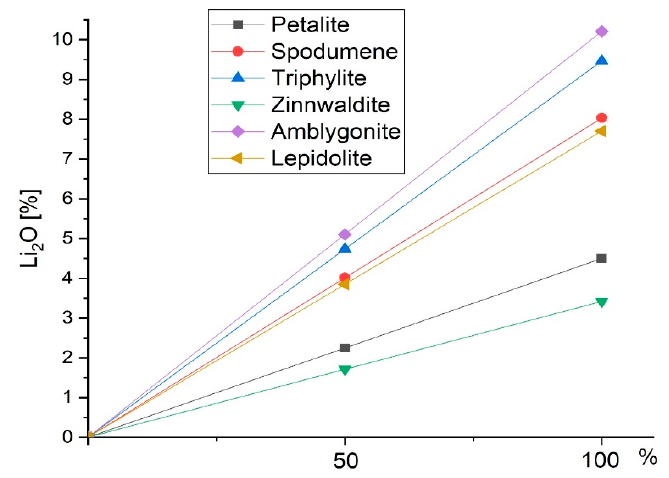
Figure 1. Maximum lithium oxide contents in different lithium minerals. Variation of lithium depending from content of the minerals (wt.%).